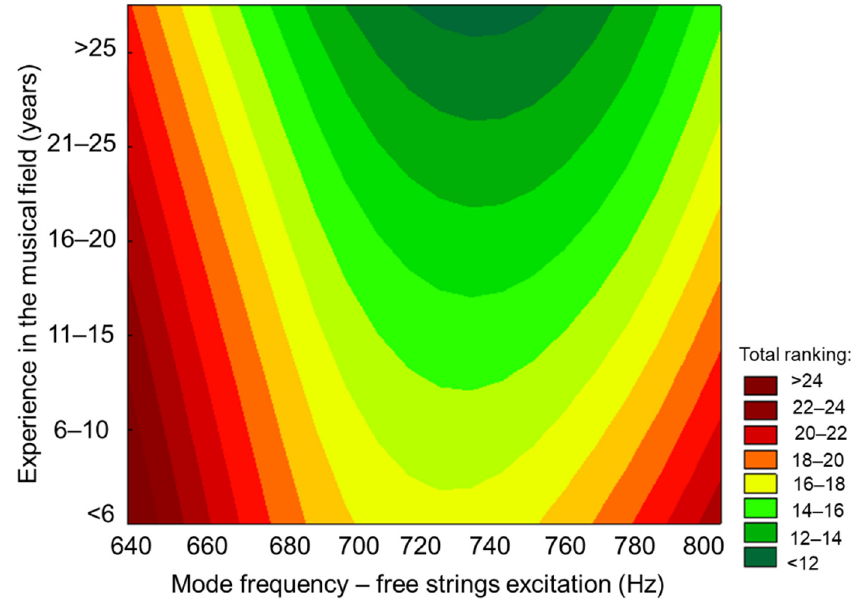
Figure 9. Contour plot, spline smoothed, of total ranking against mode frequency—free string excitation and the musical experience.